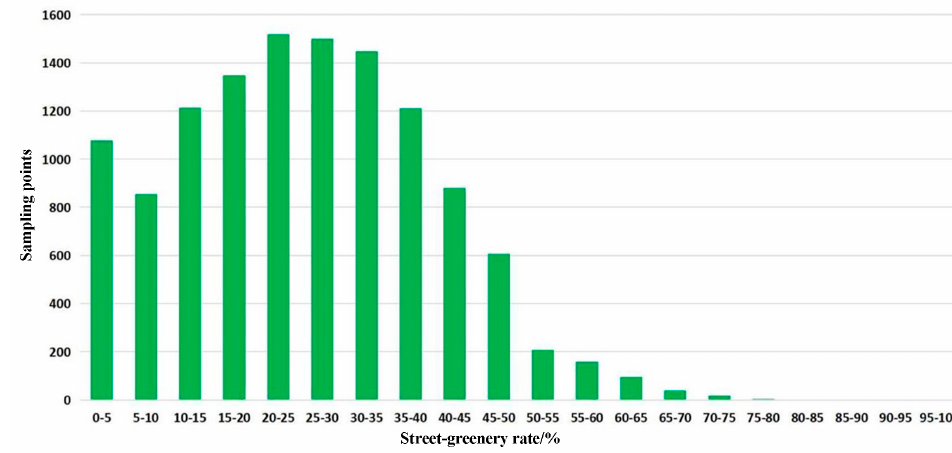
Figure 11. Statistical results of sampling points of the street-greenery rate.